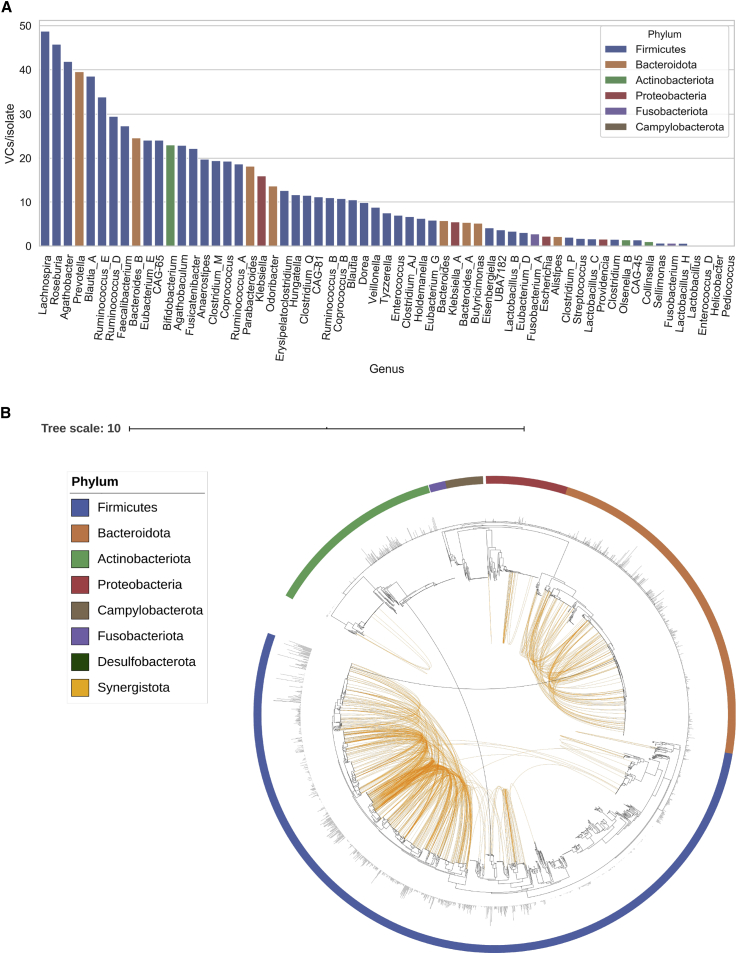
Bacterial host assignment and host range for gut phage(A) Bacterial genera with the highest viral diversity were Lachnospira, Roseburia, Agathobacter, Prevotella, and Blautia A. On the other hand, the lowest viral diversity was harbored by Helicobacter and the lactic acid bacteria Lactobacillus, Lactobacillus H, Enterococcus D, and Pediococcus.(B) Phylogenetic tree of 2,898 gut bacteria isolates showing phage host range. Host assignment was carried out by linking prophages with their assemblies and CRISPR spacer matching. Orange connections represent VCs with a very broad host range (not restricted to a single genus). Black connections represent VCs able to infect 2 phyla. Outer bars show phage diversity (VCs/isolate).